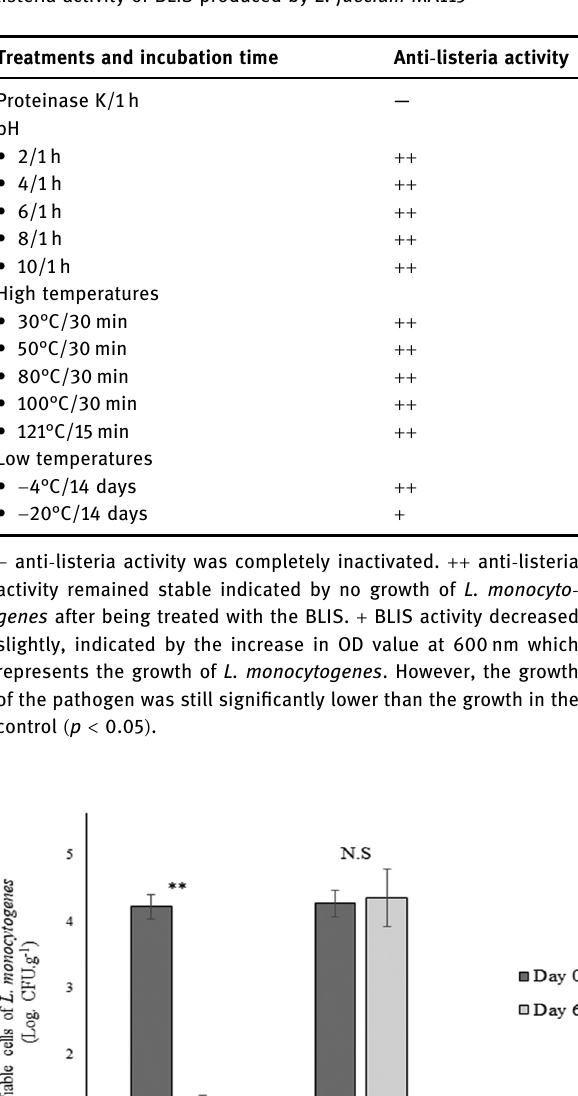
Table 1: E ff ect of proteinase K, pH, and temperatures on the anti - listeria activity of BLIS produced by E. faecium MA115